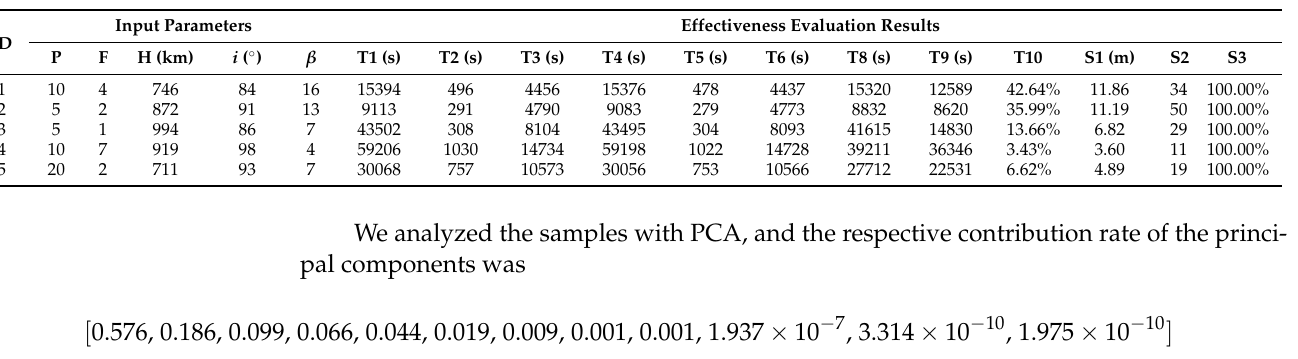
Table 4. The input parameters and effectiveness evaluation results of the first 5 samples.